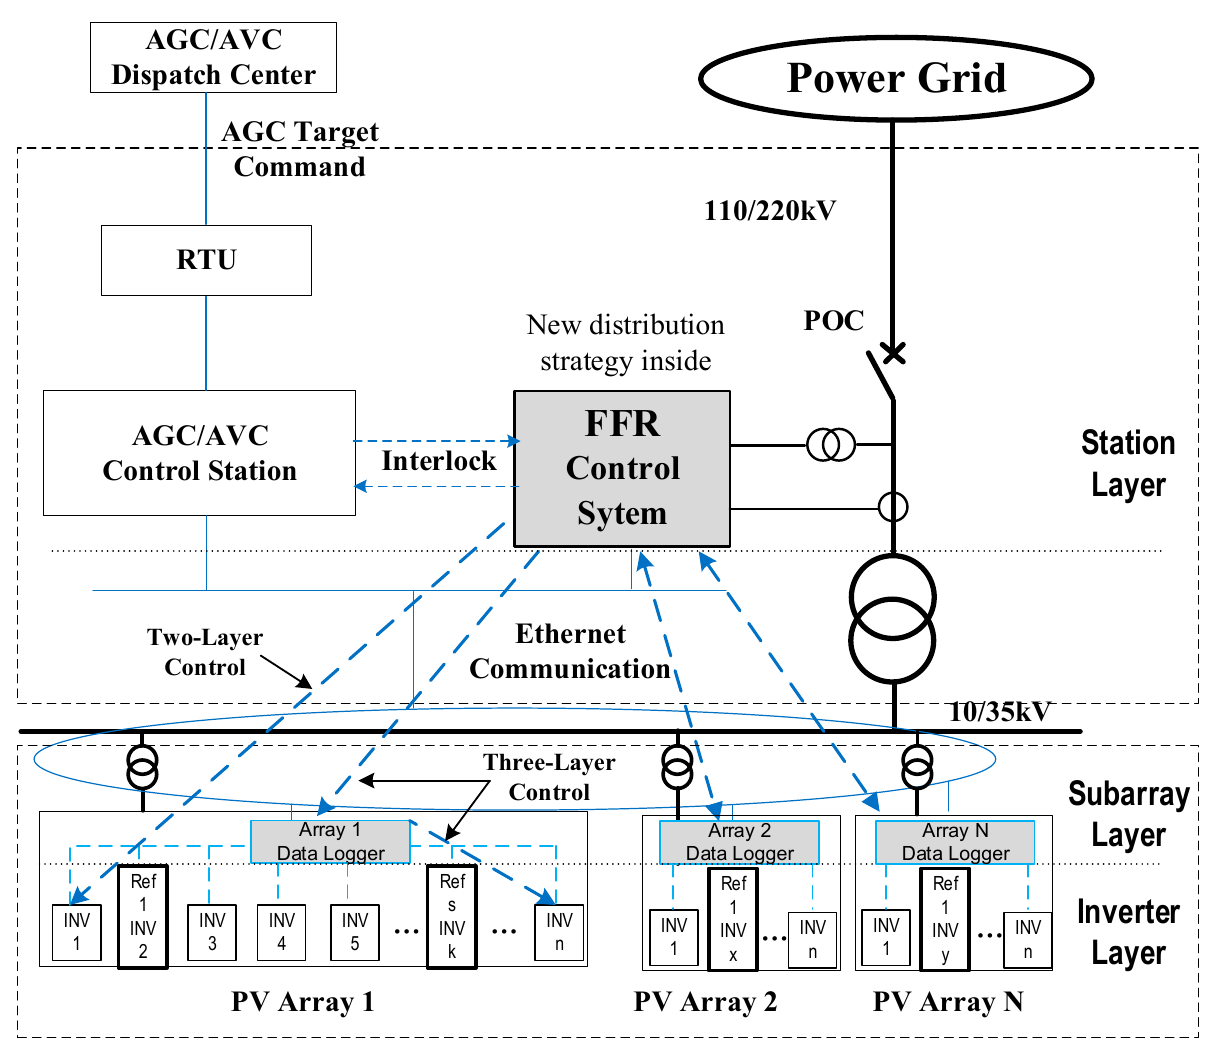
Figure 1. Two- or three-layer fast frequency response (FFR) control system structure in photovoltaic (PV) power station.